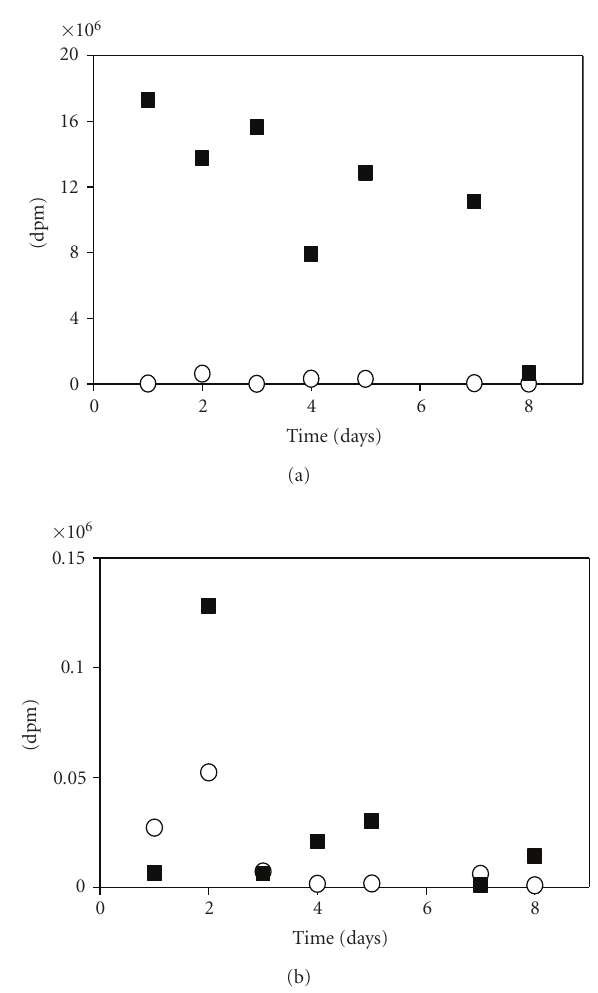
Figure 2: Clearance of radioactivity from [ 3 H]cholesterol-instilled rat lungs. Free sterol and the steryl ester fractions were isolated by TLC from BALF (circles) and postlavage lungs (squares). (a) Radioactivity in TLC band corresponding to free cholesterol. (b) Radioactivity in steryl